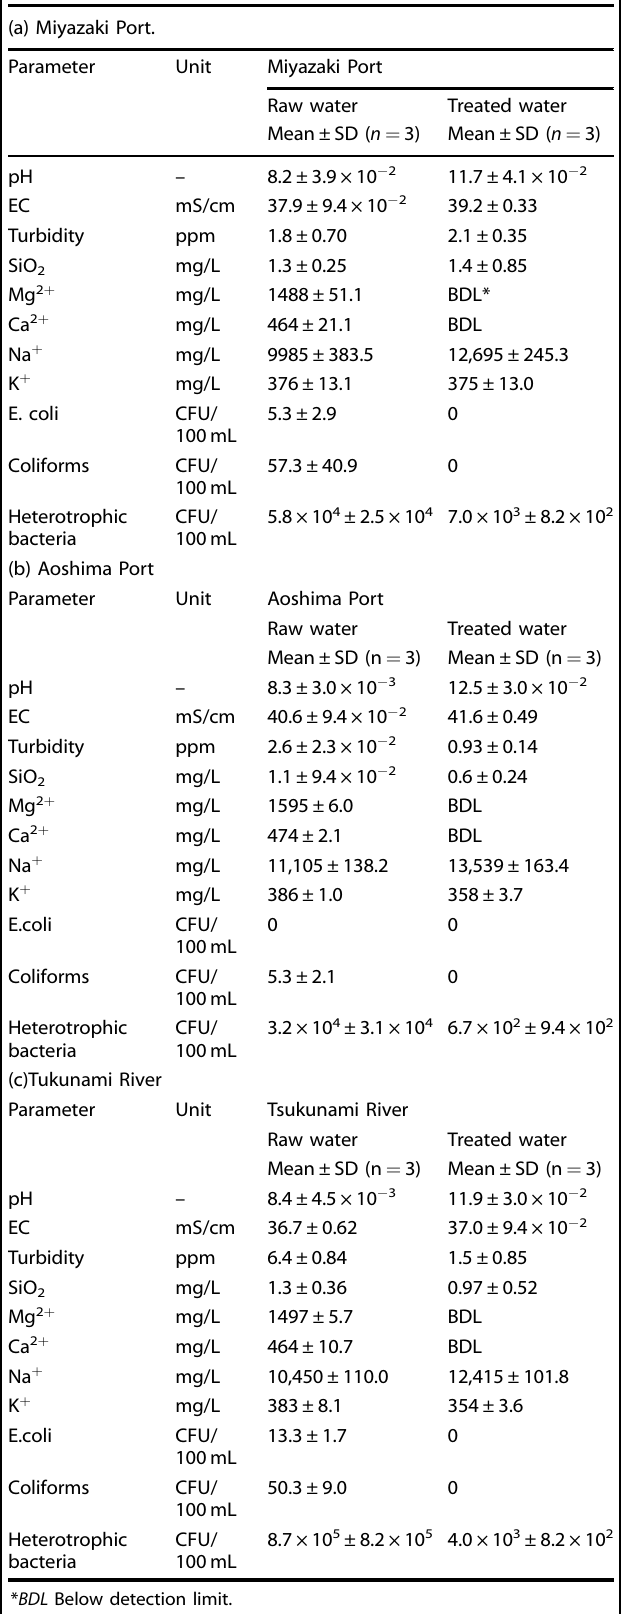
Table 1. The treatability of SBF for each water quality parameter for actual seawater.